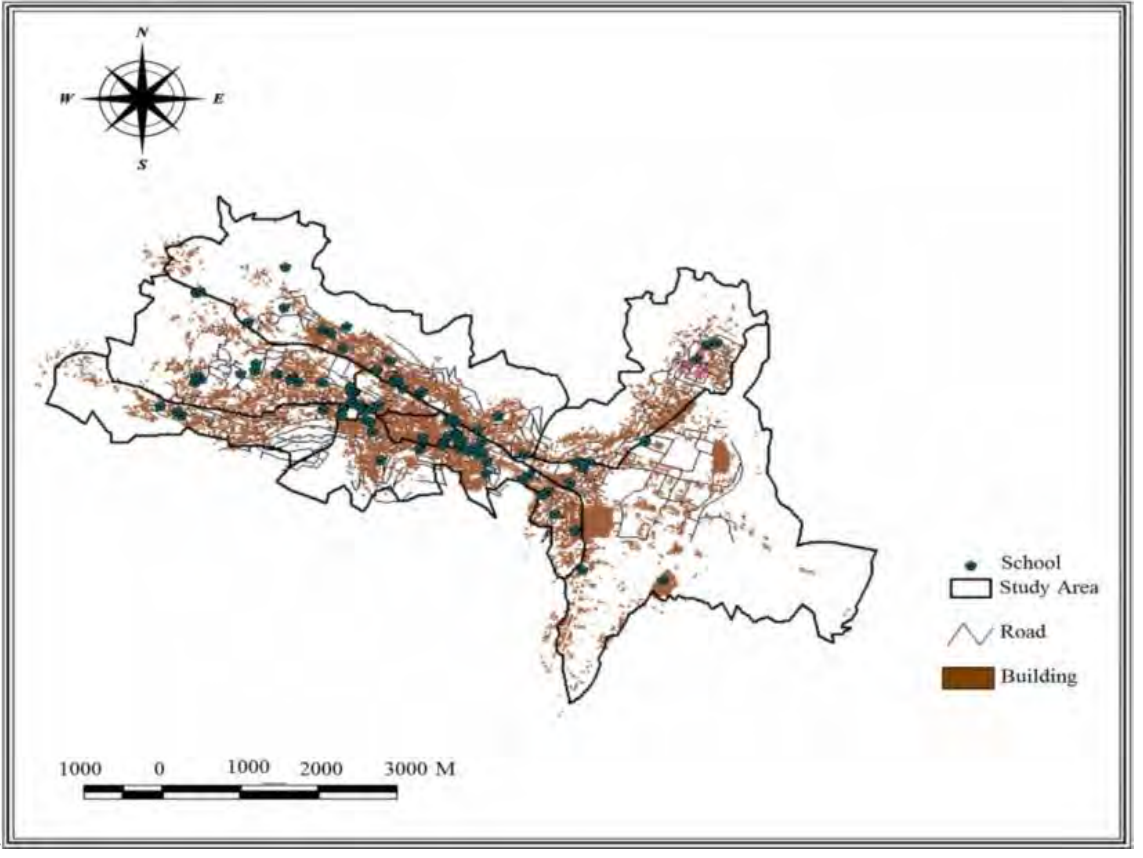
Figure 2 distributions of